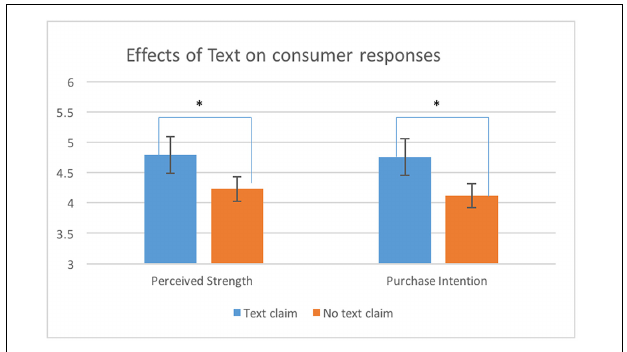
FIGURE 8 | Mean perceived strength and purchase intention ( ± SE) for packages with and without text claims. ∗ The effect is significant at 0.05